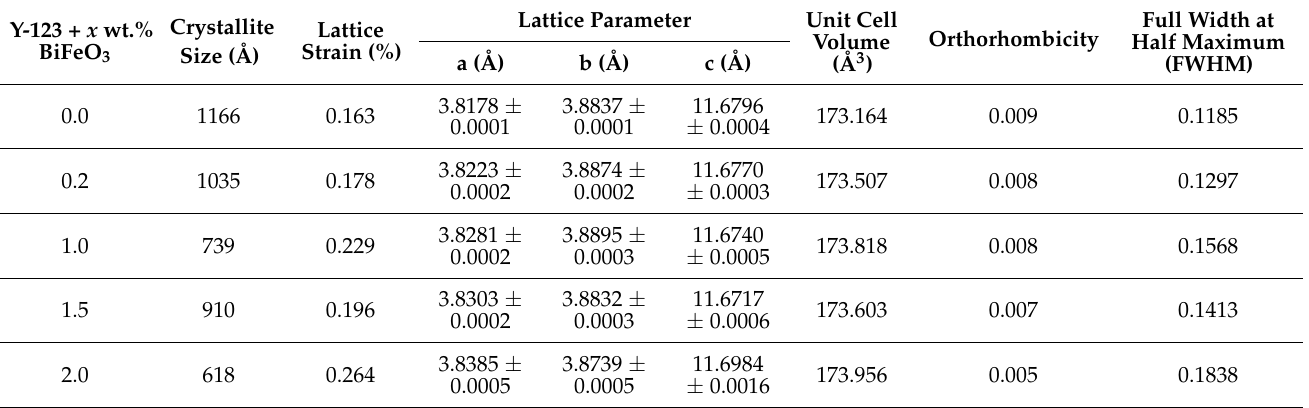
Table 2. Crystallite size, lattice strain, lattice parameters, unit cell volume, and orthorhombicity of the samples for the Y-123 + x wt.% of BiFeO 3